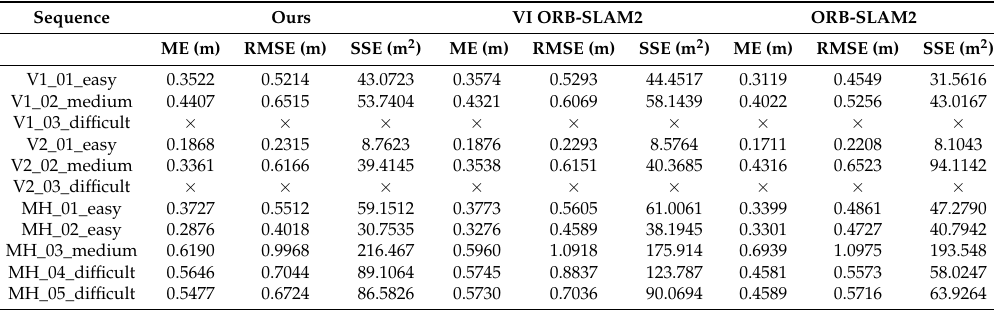
Table 2. The accuracy of keyframe trajectories generated by visual–inertial ORB-SLAM2 (VI